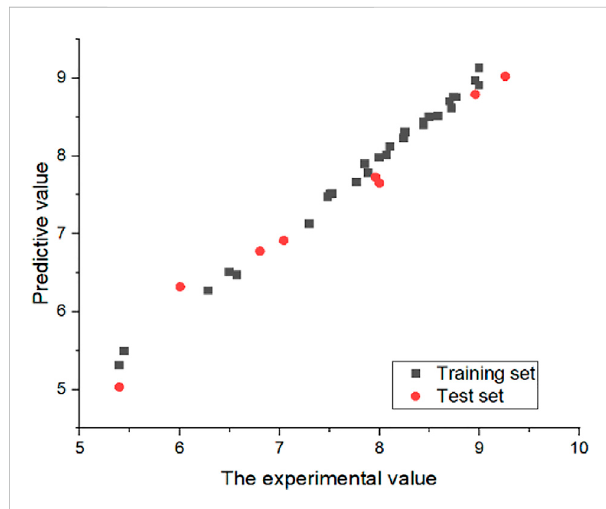
FIGURE 6 Experimental and predicted values of CoMSIA model. All compounds IC 50 were converted to “ − log(IC 50 )+9.